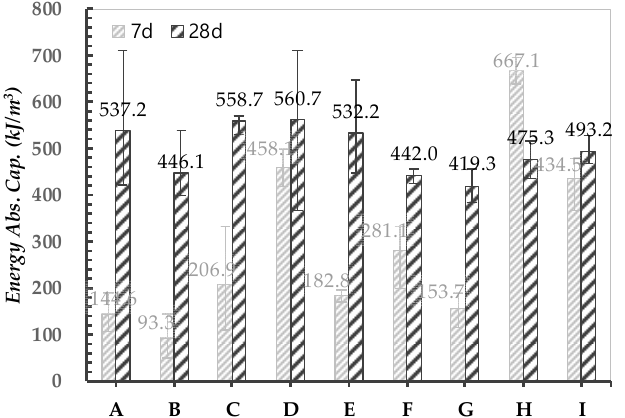
Figure 14. The energy absorption capacity of 7 d and 28 d cured specimens. As the curing time increased to 28 d, the energy absorption capacity increased enor- mously as compared to that of 7 d cured specimens except for specimen H. Specimens D28, F28, and H28 with smaller dosages of GGBS, SF, and CKD exhibited energy absorption capacities of 560.7 kJ/m 3 , 442.0 kJ/m 3 , and 475.3 kJ/m 3 , respectively. Moreover, energy absorption capacities of specimens E28, G28, and I28, with higher dosages of mineral ad- ditives, were measured at 532.2 kJ/m 3 , 419.3 kJ/m 3 , and 493.2 kJ/m 3 , respectively. Unlike in the case of 7 d cured specimens, the increase in the contents of the mineral additives did not cause significant decreases in the energy absorption capacity of the 28 d cured speci- mens. In the case of GGBS and SF, this is attributed to the slower rate of reaction than that of OPC. On the other hand, in the case of CKD, the higher energy absorption capacity of specimen I28, as compared to that of H28, can be attributed to the fast reaction of the materials and the lower amount of the total hydrates, as discussed earlier. The higher amount of the non-reactive silica flour also resulted in the higher energy absorption ca- pacity of specimen C than that of specimen B at both 7 d and 28 d. Specimens A28, B28, and C28 exhibited significantly increased energy absorption capacities as compared to those of the 7 d cured specimens with values of 537.2 kJ/m 3 , 446.1 kJ/m 3 , and 558.7 kJ/m 3 , respectively. 4.2.5. Ratio of Test Parameters Figure 15 shows the ratios of the test parameters at 7 d and 28 d, namely, compressive strength, tensile strength, strain capacity, and energy absorption capacity. As mentioned previously, it was noted that most of the 7 d cured specimens exhibited higher tensile strength than those of 28 d cured specimens, unlike in the case of the compressive strength. All the 7 d–28 d tensile strength ratios were higher than 77%, and most of them exceeded 100%, whereas those of the compressive strength ranged between 76% and 94%. This denotes that the tensile strength was not proportional to the development of com- pressive strength. Meanwhile, the 7 d–28 d strain capacity ratios were measured down to 16%. As discussed previously, this can be attributed to the porous and irregular micro- structure and to large particles at the fiber–matrix interface of the 7 d cured specimens. For the energy absorption capacity, the 7 d–28 d ratios also measured below 88% except for specimen H, which was measured as 140%. Furthermore, it is also noted that the 7 d– 28 d ratios for the energy absorption capacity significantly increased as GGBS, SF, CKD was incorporated into the mix. This denotes that the property and development of the microstructure primarily influence the tensile performance when considering the results of microstructural inspections.